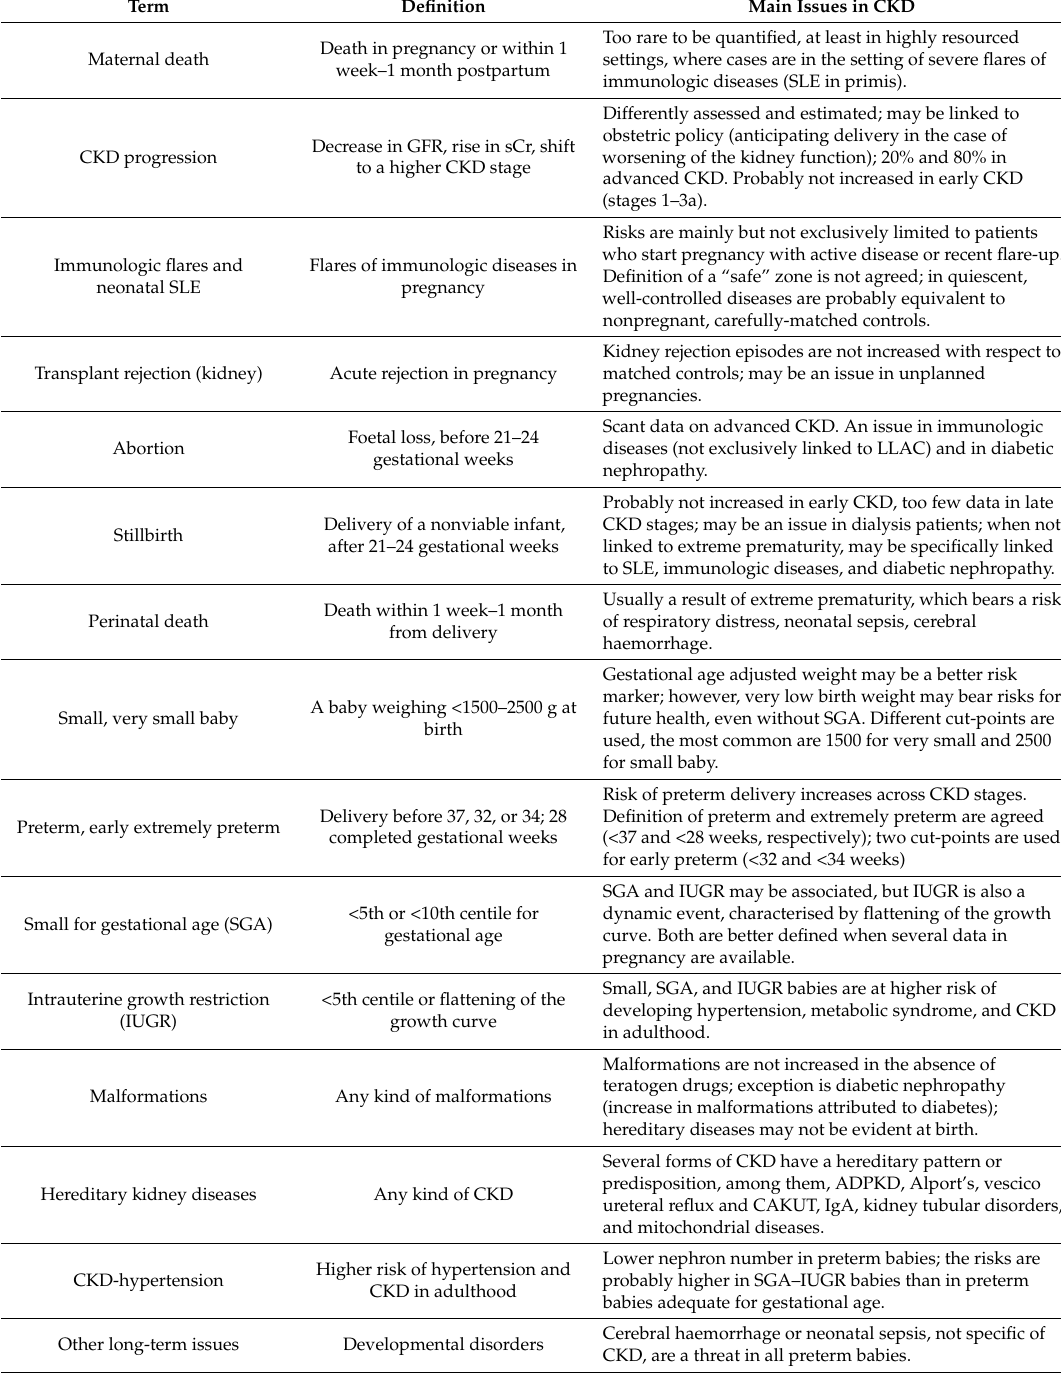
Table 2. Adverse pregnancy outcomes in CKD patients and in their offspring